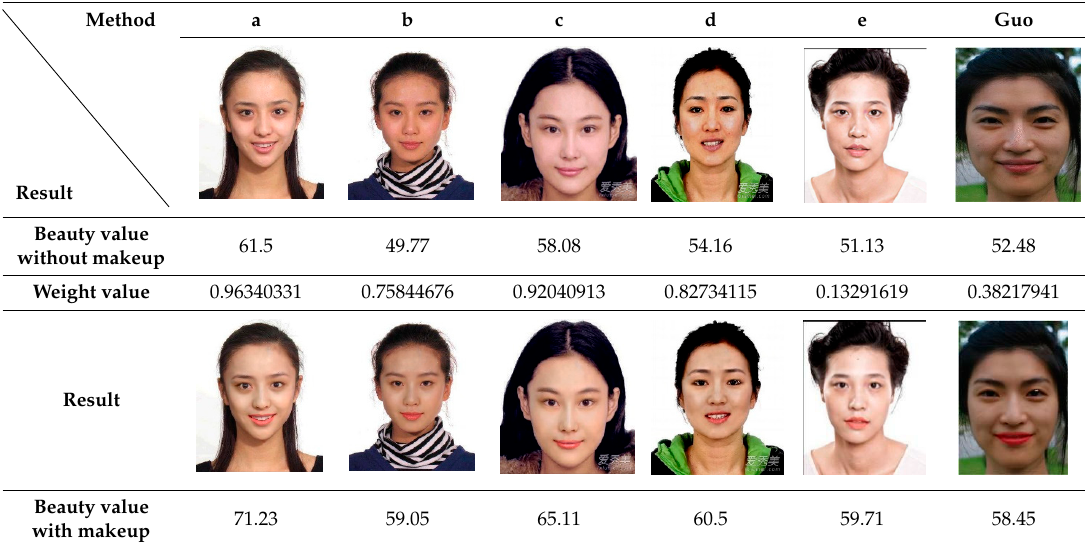
Table 6. Different girls wear the same makeup.